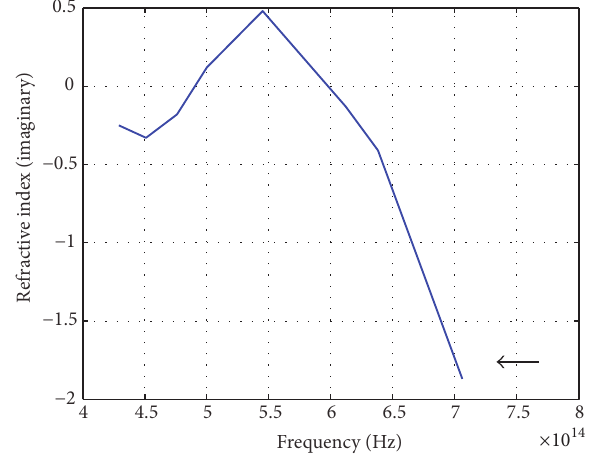
Figure 21: Plot showing how the refractive index (imaginary) changes with frequency for a radius ratio of 2 and fixed inner and outer radius value (arrow shows no further values can be achieved beyond a frequency of